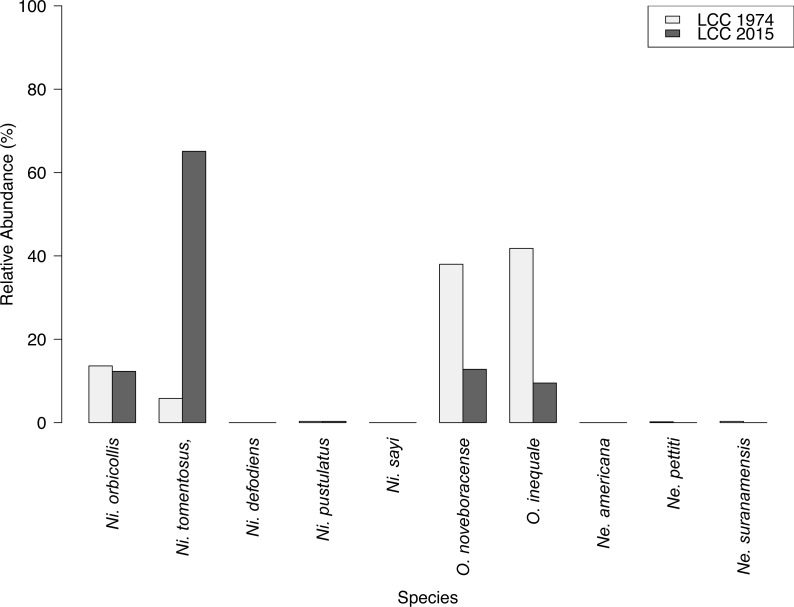
Relative abundance of species at the Louis Calder Center site in 1974 (Pirone & Sullivan, 1980) and in 2015.